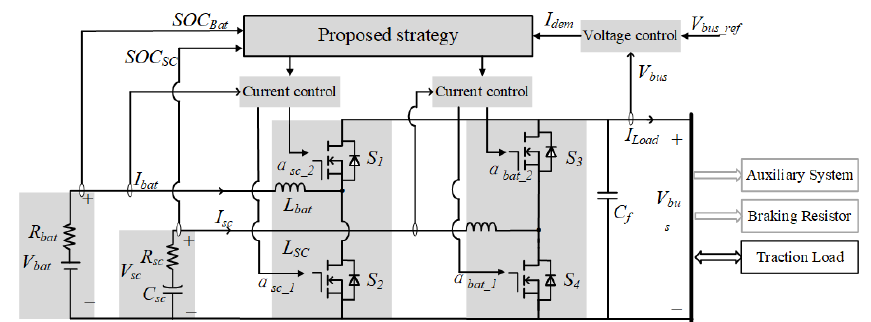
Figure 1. Configuration of the proposed hybrid energy management system for the electric vehicle